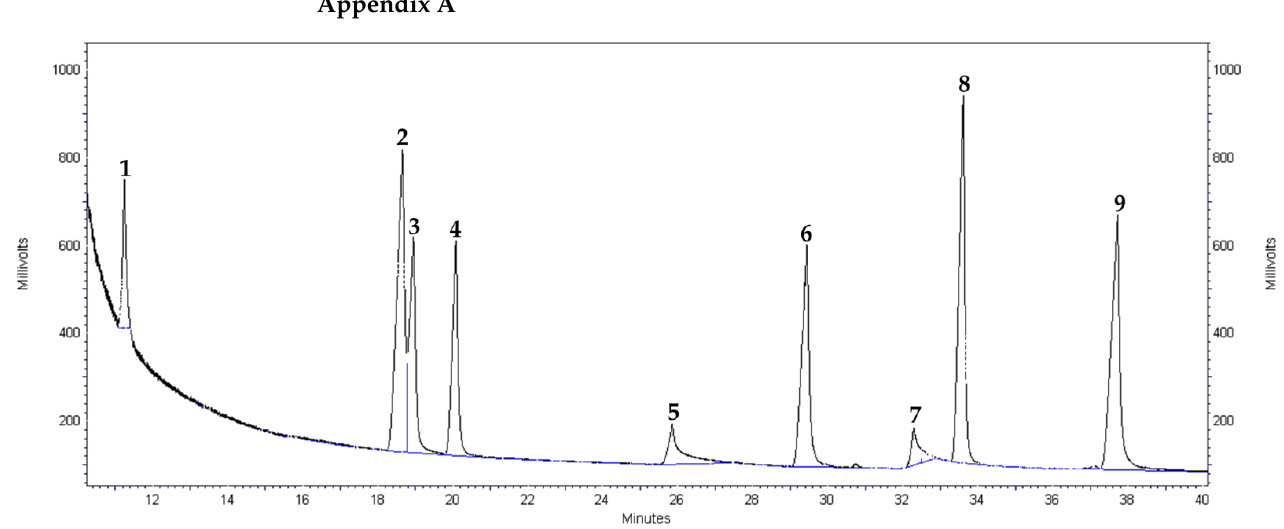
Figure A1. Chromatogram obtained from the mix of standards of volatile compounds: (1) 2,3- butadione at 588.6 µ g mL − 1 , (2) limonene at 504 µ g mL − 1 , (3) isoamyl isobutyrate at 513.6 µ g mL − 1 , (4) trans-2-hexen-1-al at 507.6 µ g mL − 1 , (5) 1-hexanol at 488.4 µ g mL − 1 , (6) hexyl-3-methyl butanoate at 514.2 µ g mL − 1 , (7) 3,3-dimethyl-1-hexanol at 514.2 µ g mL − 1 , (8) linalool at 522 µ g mL − 1 , and (9) cis-3-hexenyl hexanoate at 528 µ g mL − 1 .